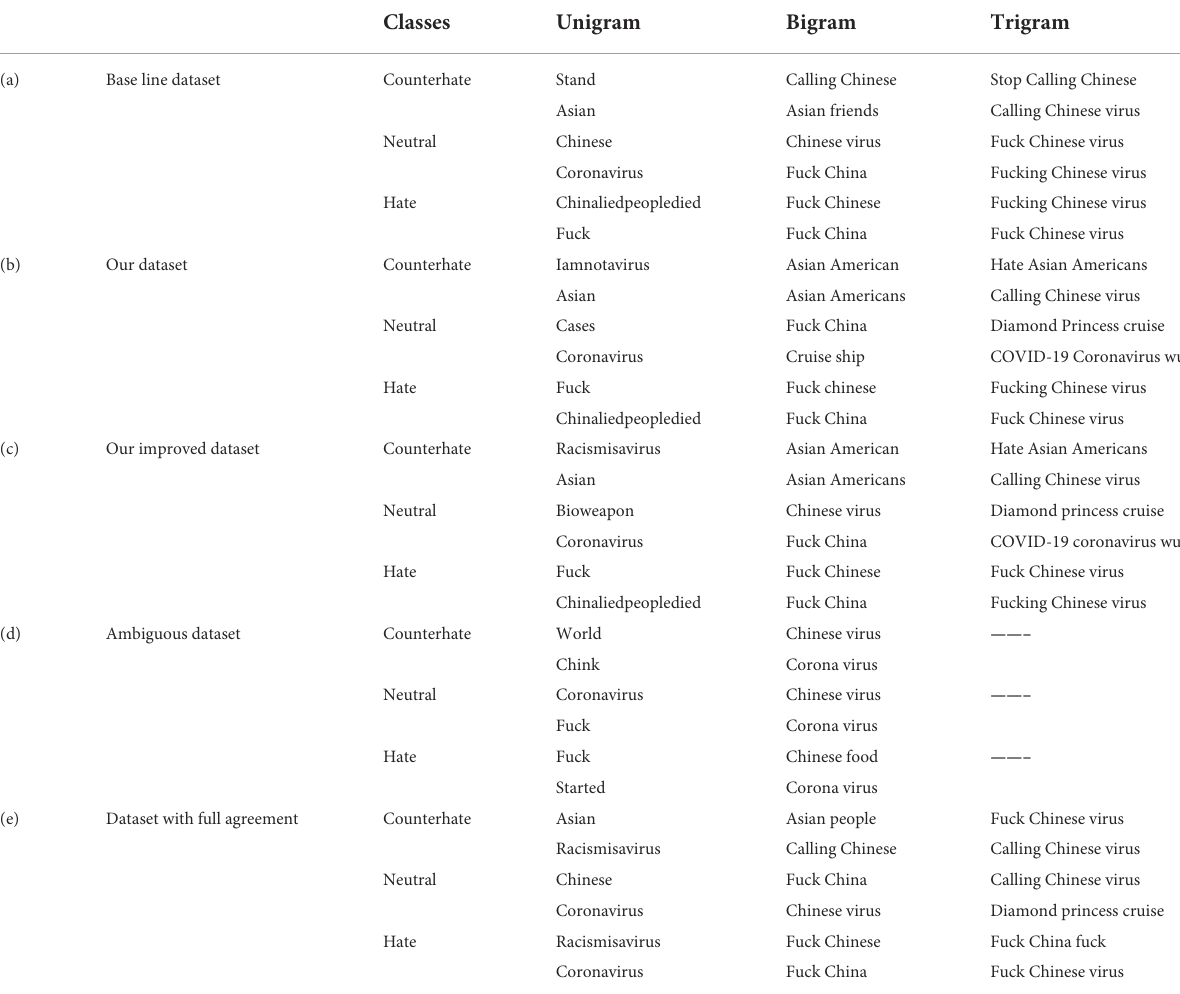
TABLE 1 Most frequent phrases for each category in each